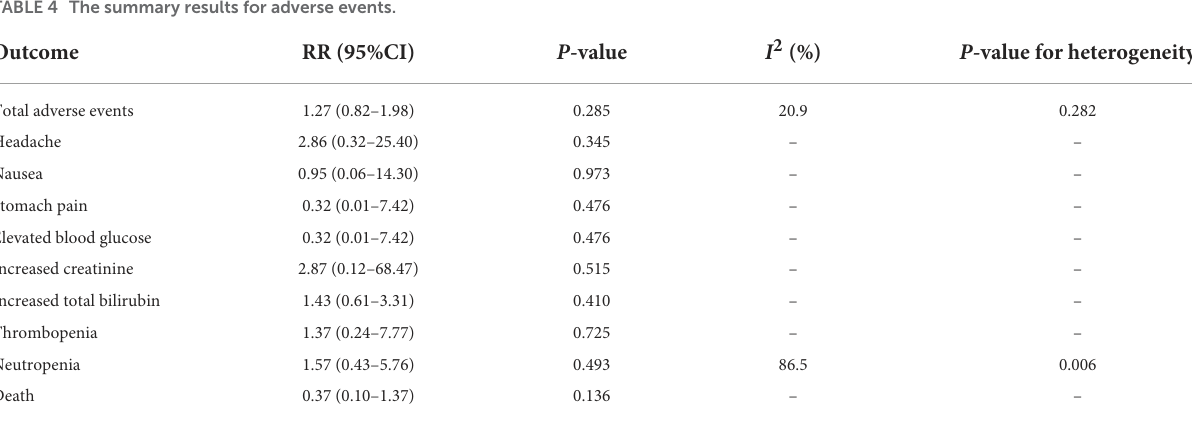
TABLE 4 The summary results for adverse